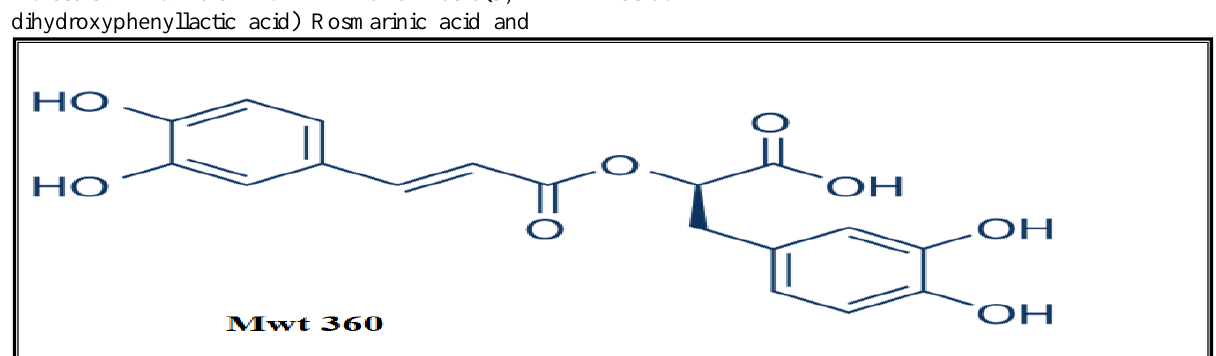
Molecular ion peak at m/z359[M-H] of Rosmarinic acid.